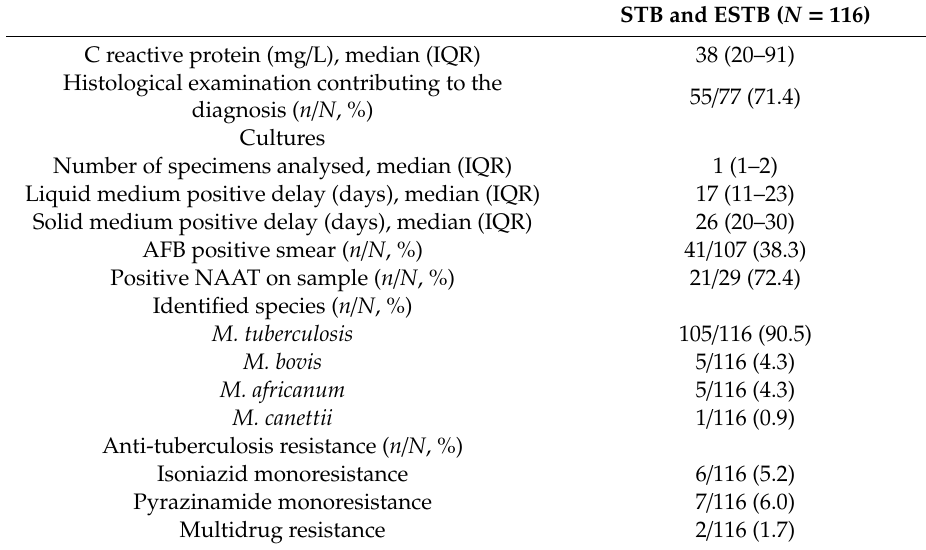
Table 3. Laboratory results for bone and joint